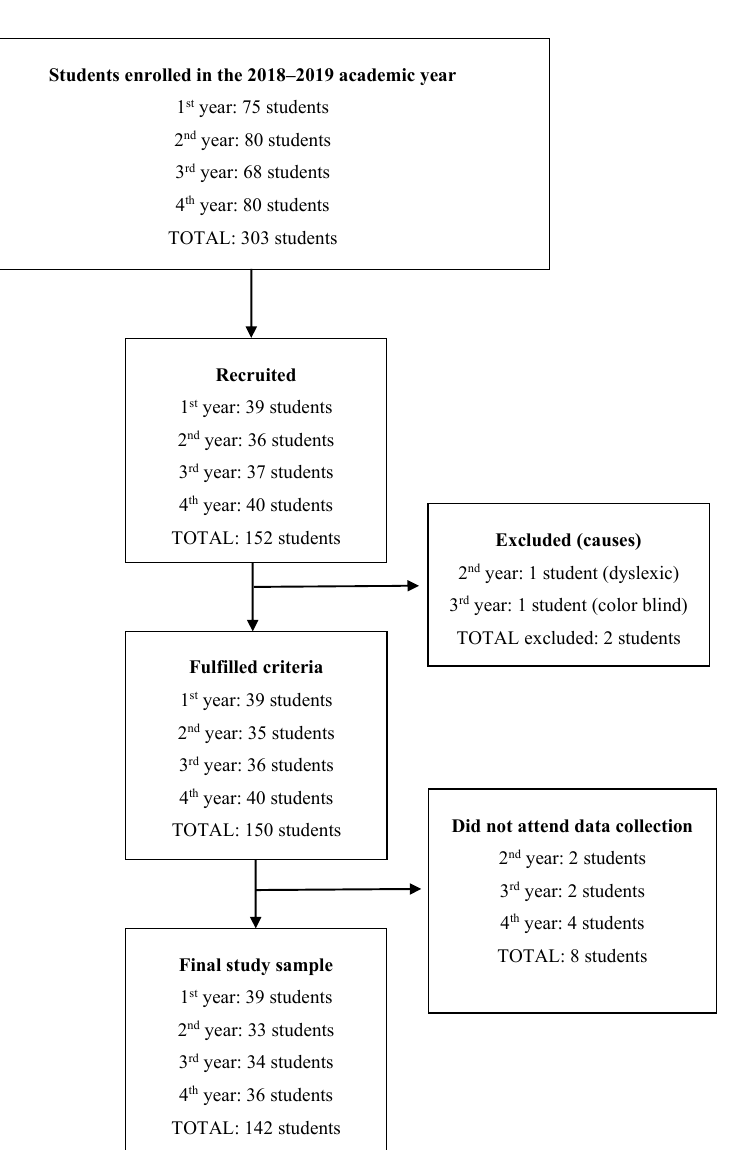
Figure 1. Diagram of study participation.